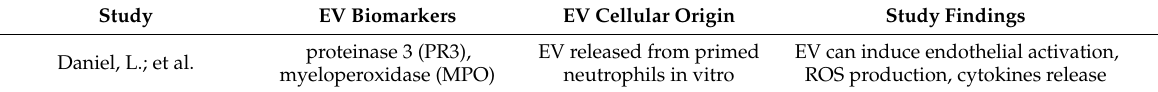
Table 4. Extracellular vesicles in ANCA-associated